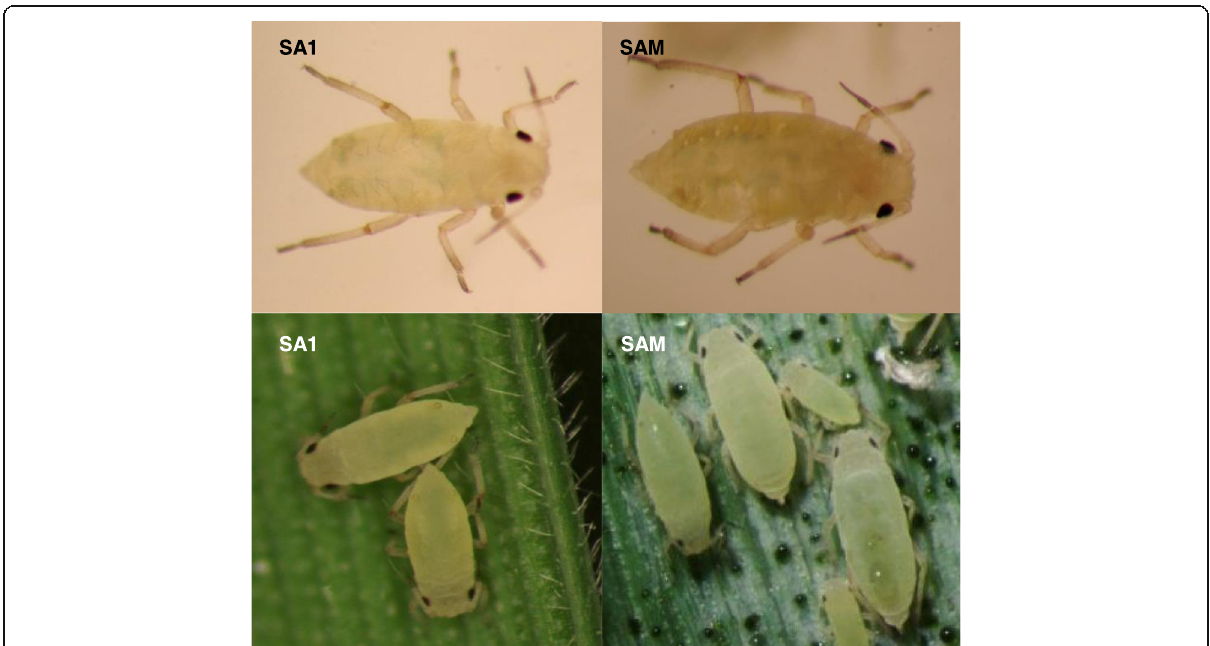
Fig. 1 Photomicrograph of South African Diuraphis noxia biotypes SA1 and